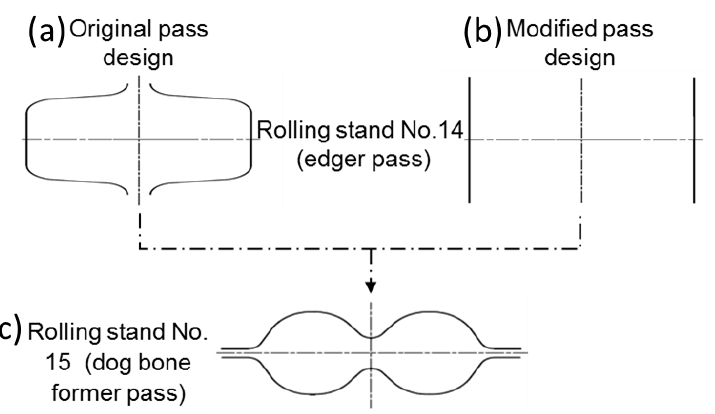
Figure 3. Schematic of the roll pass of stand 14. ( a ) Original grooved rolls, ( b ) modified grooveless roll, and ( c ) stand 15 with dogbone pass.